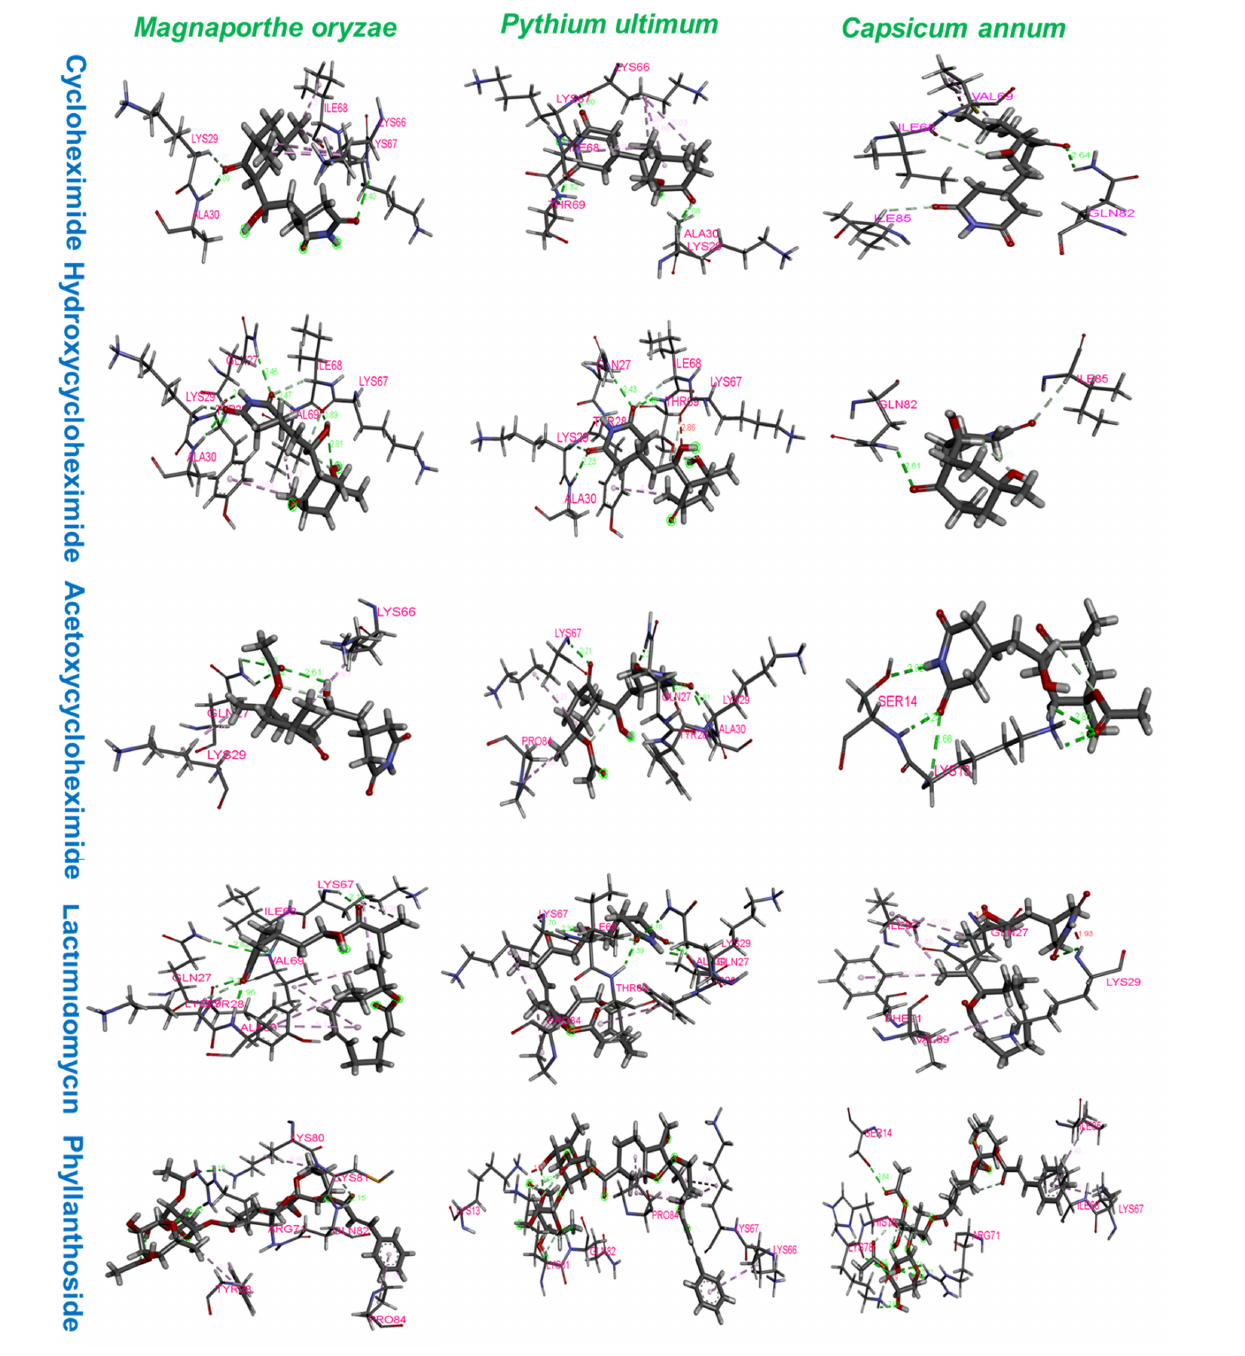
FIGURE 4 | Amino acid residues interactions of ribosomal proteins of Magnaporthe oryzae, Pythium ultimum, and Capsicum annum with cycloheximide, hydroxycycloheximide, acetoxycycloheximide, lactimidomycin, and phyllanthoside, respectively, where lactimidomycin and phyllanthoside used as the positive